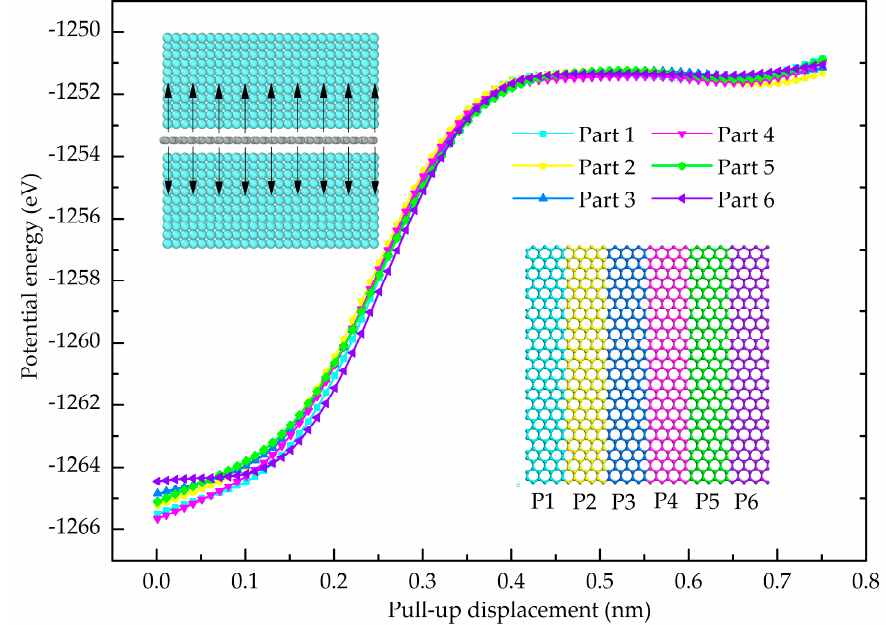
Figure 3. Variation of the potential energy of every part during pull-up process, the inserted figure is the segmentation of graphene sheet in pull-up test and the schematic diagram of load transfer at the interface.